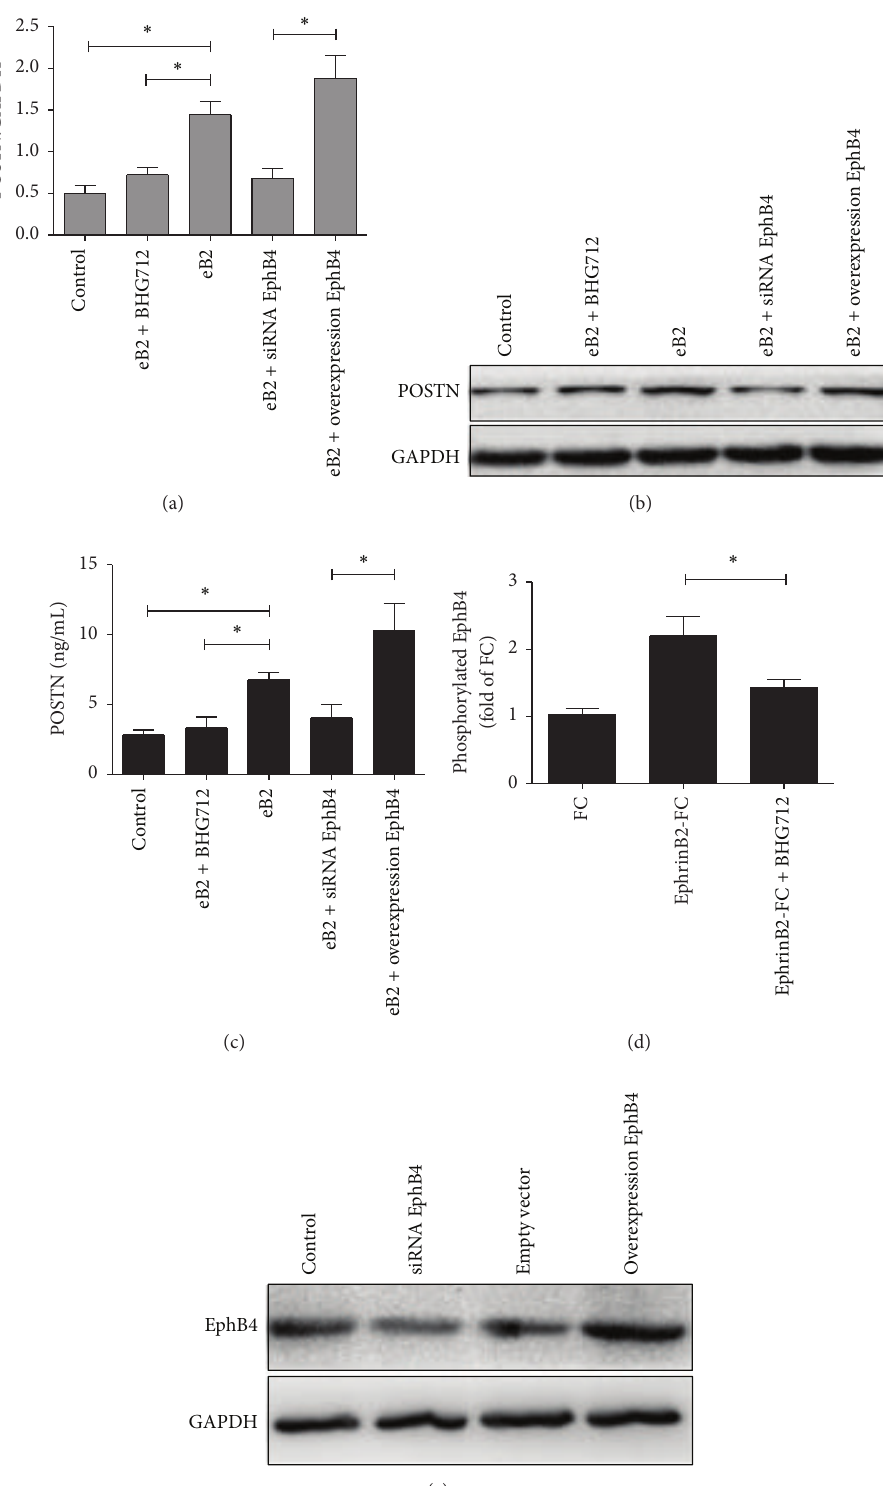
Figure 2: Activation of EphB4 increased POSTN expression in MSCs. (a) POSTN mRNA levels were quantified by real-time PCR upon stimulation with ephrinB2-FC (eB2) for 72 h in serum-free medium. Untreated MSCs were used as the control. Bars represent means ± SD from 3 biological replicates relative to GAPDH controls; ∗ 𝑃 < 0.05 . (b) Protein expression of POSTN was detected using western blotting under the same conditions. (c) The concentration of POSTN in the serum-free medium was assessed by ELISA. Bars represent means ± SD from 3 biological replicates; ∗ 𝑃 < 0.05 . (d) The level of phosphorylated EphB4 was detected by ELISA using starved MSCs after stimulation with ephrinB2-Fc (4 𝜇 g/mL) for 20 minutes. Fc was used as the control. (e) The efficiency of siRNA and overexpression of EphB4 were evaluated by western blot analysis. MSCs alone were used as the